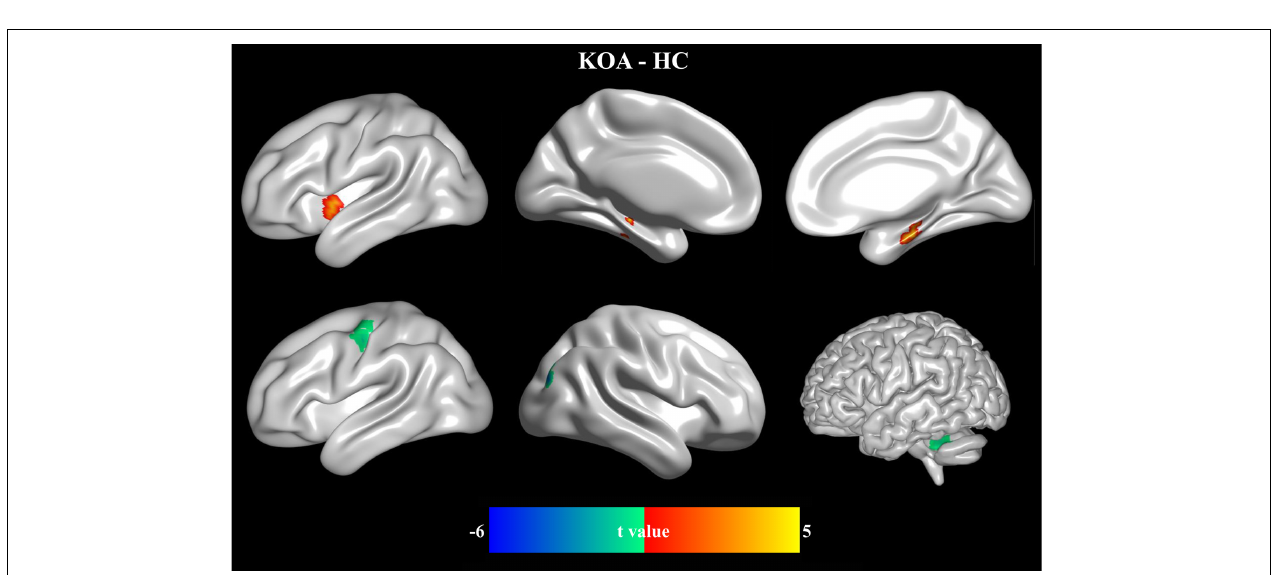
FIGURE 2 | Reduced GMVs in patients with KOA. Compared with HC, the patients with KOA pain showed lower GMV in the bilateral insula and hippocampus.